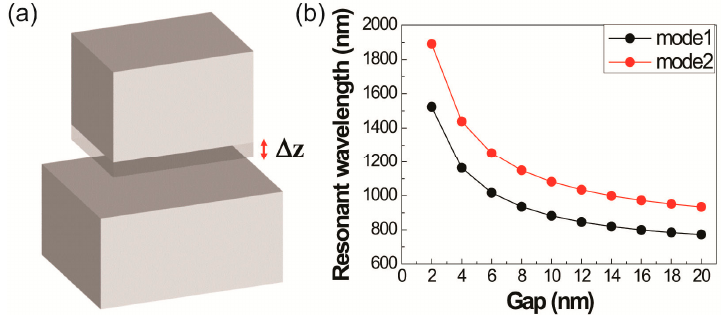
Figure 6. ( a ) A schematic diagram of the vertical movement of the small upper block with a shift of Δ z without a lateral movement. ( b ) Resonant wavelengths of mode 1 (M1) (black) and mode 2 (M2) (red) as functions of gap thickness.